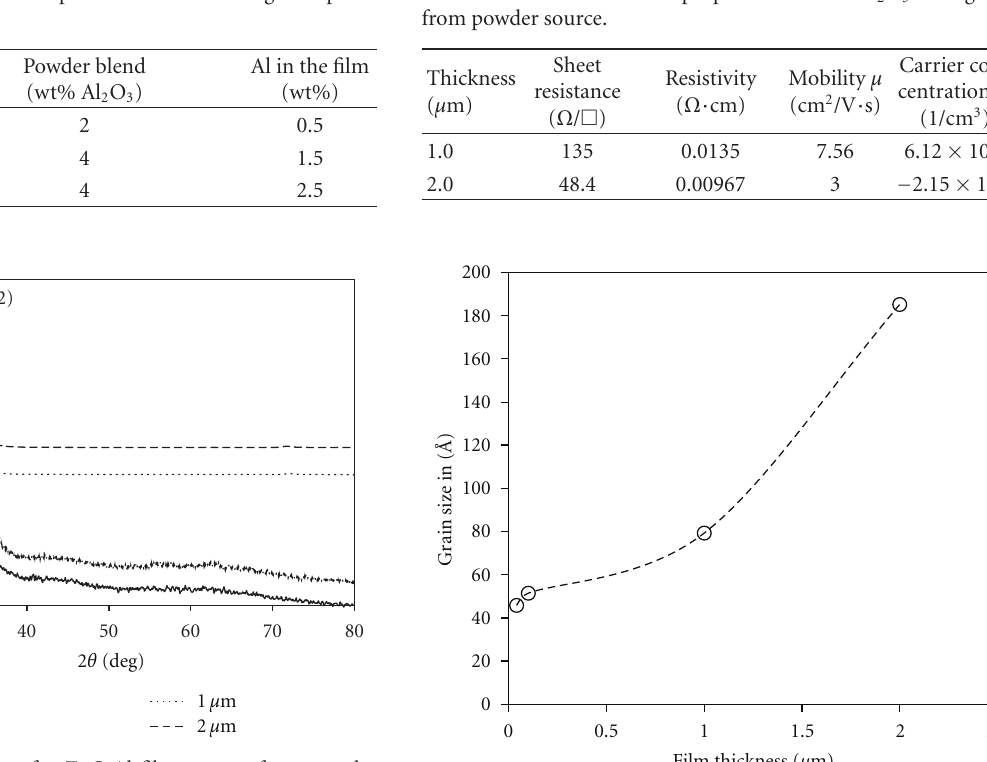
Figure 5: XRD θ /2 θ scans for ZnO:Al films grown from powder source with di ff erent thickness.